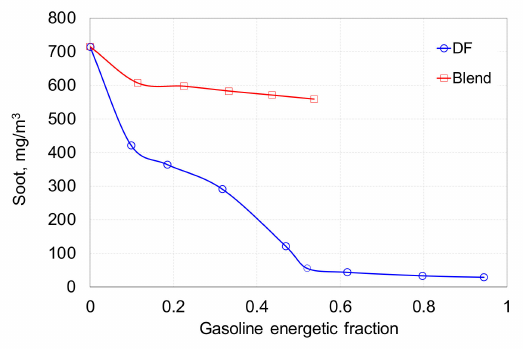
Figure 18. Soot emission changes for dual fuel and blend